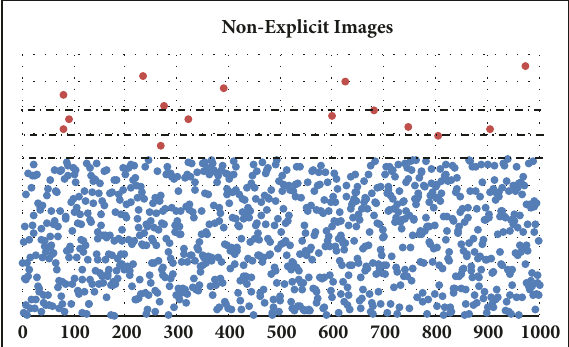
Figure 11: Result graph of application of the proposed ECD system on 1000 explicit dataset images.